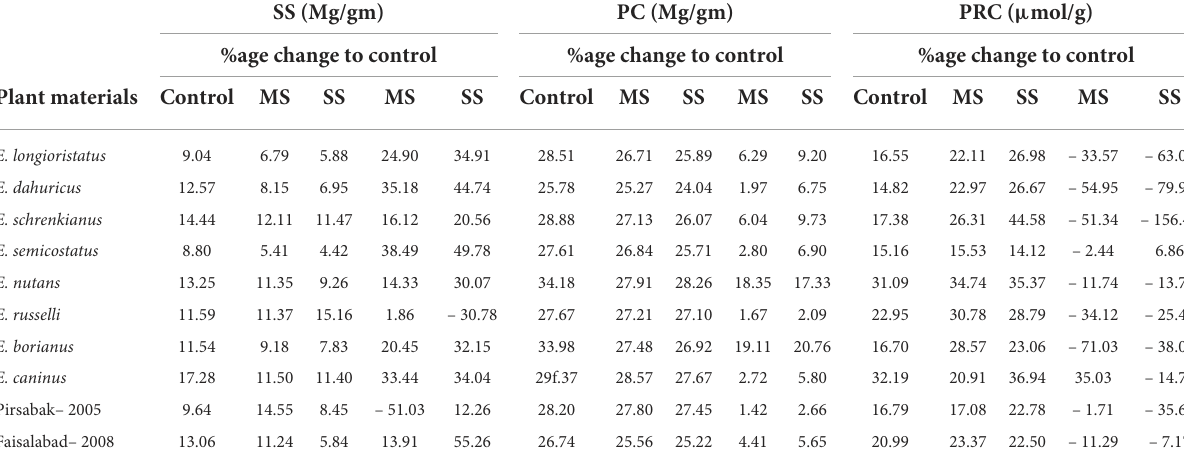
TABLE 4 Variability in soluble sugars, protein content, and proline content in Elymus species and wheat cultivars under drought stress. SS (Mg/gm) PC